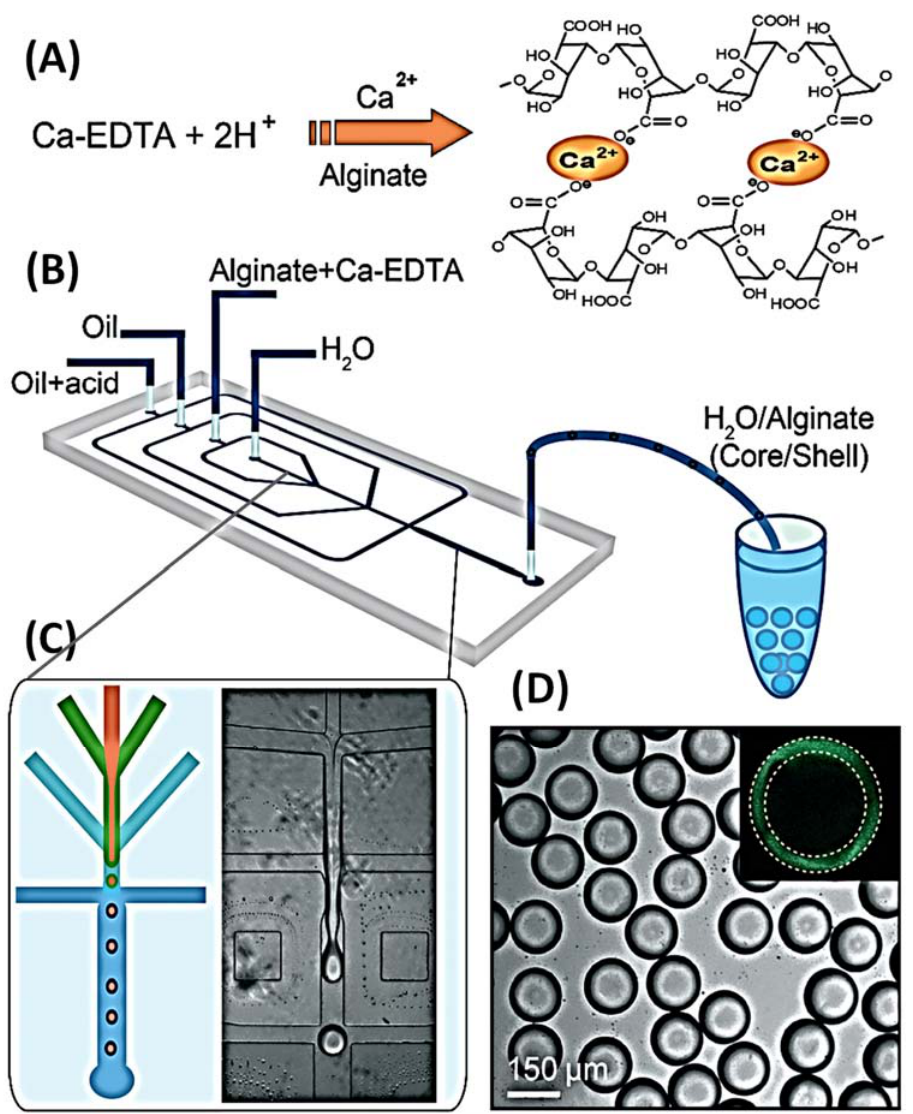
Figure 7. Schematic diagram of the creation of a three-dimensional scaffold in a droplet (composed of a water nucleus and a hydrogel shell): ( A ) Principle of obtaining alginate networks. ( B ) PDMS Microfluidic chip. ( C ) Alginate cross-linking in the Microfluidic chip. ( D ) Fluorescein-labeled alginate as shown in the inset where the shell of alginate hydrogel was found under confocal microscopy. The image from [48], Copyright 2016, Royal Society of Chemistry.